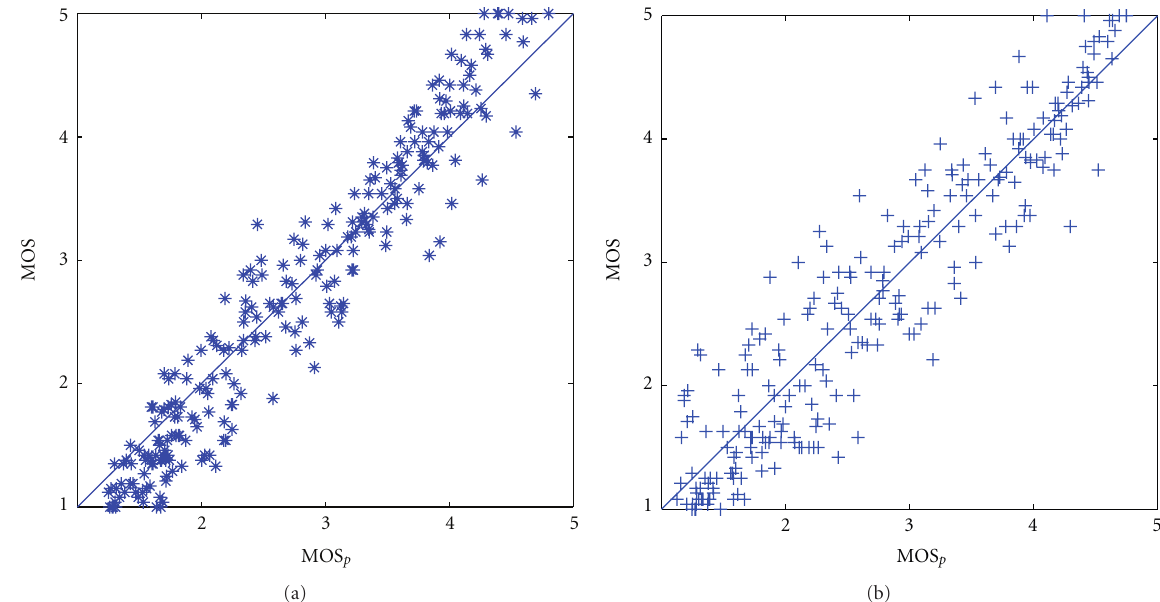
Figure 14: Proposed method’s MOS versus MOS p . (a) Training, (b) Testing.